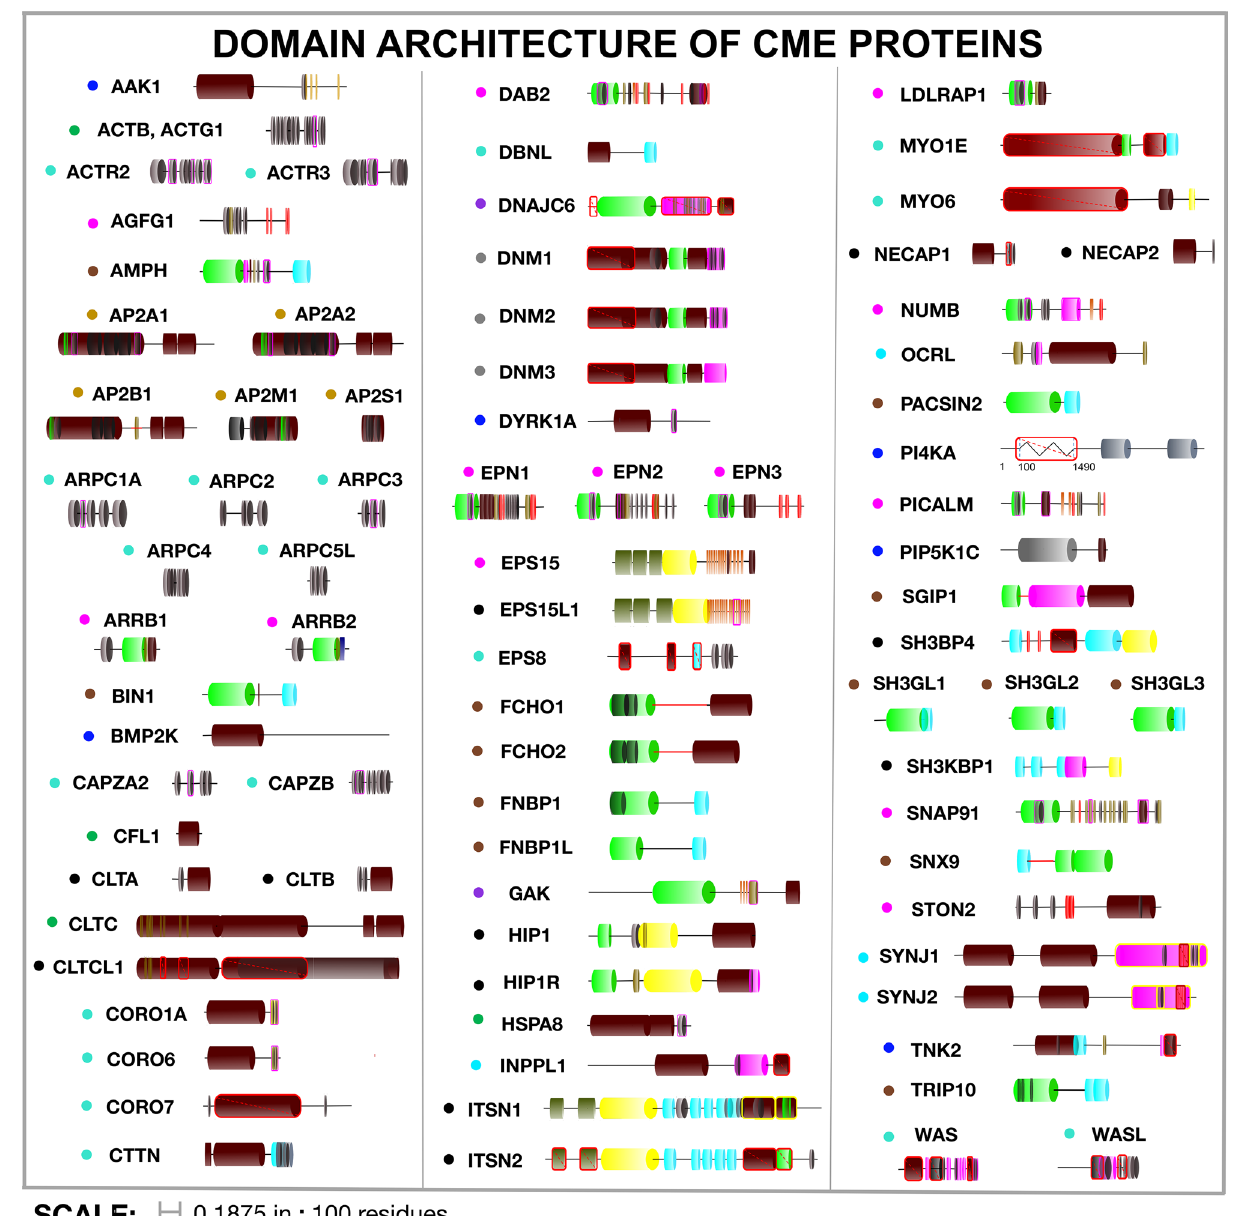
Figure 1. Domain and interface architecture of 82 CME proteins in our human interface-resolved protein network. Information on interfaces was curated from SMART 50 and low-throughput studies, where structured domains are in some cases subdivided by residues that represent binding interfaces (e.g. the five AP-2 genes indicate where they bind the other A/α, B/β, S/σ, M/μ subunits). The colored dot next to each protein name indicates the class to which we have assigned it: the central AP-2 adaptor subunits in mustard yellow, other cargo adaptor proteins in pink, kinases in dark blue (which act on proteins and lipids), phosphatases in light blue (which act only on lipids), dynamins in gray (necessary for vesicle fission), enzyme co-factors of the ATPase chaperone protein HSC70/HSPA8 in purple (needed for disassembly of cages), BAR (bin/amphiphysin/rvs) domain proteins in brown, cytoskeletal proteins in mint, and a group of always-abundant proteins in green. Protein length is scaled to reflect residue length, with distinct domains shown in colors, including structured domains and SLiMs that mediate binding. Red outlines indicate domains that are not present in our network, as we did not find any interacting partners for them; it does not mean they cannot mediate any protein interactions. Domains are colored: SH3 (blue), PRD/proline-rich domain (pink), lipid binding (green), coiled- coil (yellow), other structured